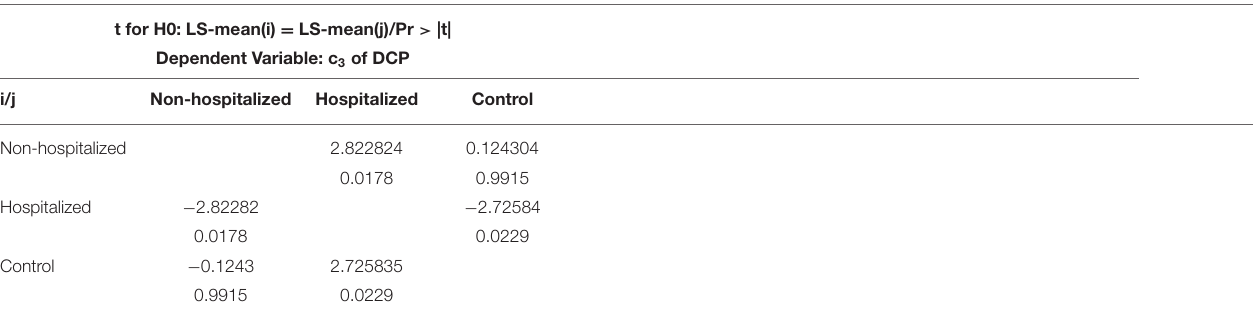
Table 3 . Considering fine variations of VD, a circular analysis was done: VD of c 2 ( p = 0.0468) and c 3 of the DCP ( p = 0.0232) and VD of c 1 of the SVP ( p = 0.0465) were significantly reduced in patients post − COVID being hospitalized vs. non-hospitalized during SARS-CoV-2 infection. Comparing this two subgroups of patients post − COVID with controls, VD of c 3 of the DCP was significantly reduced in hospitalized < non-hospitalized < controls ( p = 0.015), yet not c 2 (DCP) and c 1 (SVP, p > 0.05). The comparison of each group with its respective p -value can be seen in Table 2B . In addition, no differences were observed for c 1 (DCP); c 2 and c 3 (SVP); c 1 , c 2 , and c 3 (ICP); and c 1 , c 2 , and c 3 (peripapillary) of hospitalized vs. non-hospitalized patients post − COVID ( p >